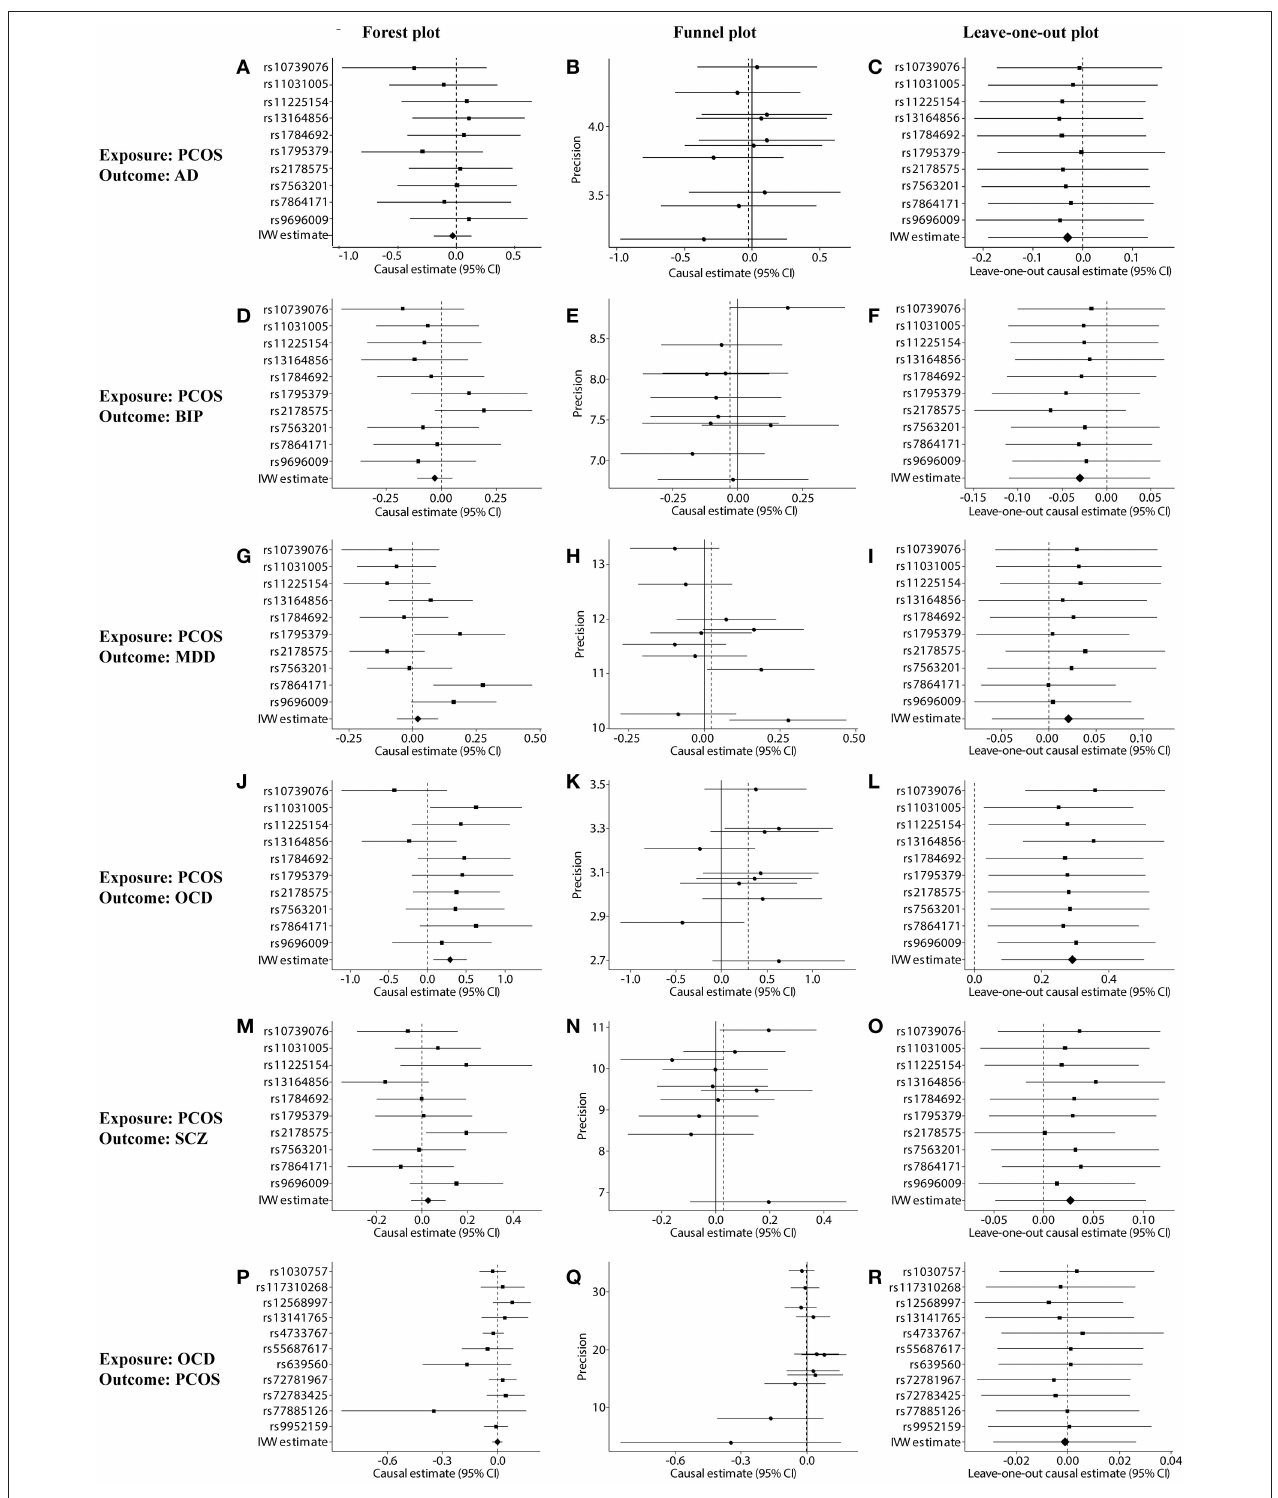
FIGURE 2 | Sensitivity tests of forward and reverse Mendelian randomization (MR) analyses. (A–O) Forest, funnel, and leave-one-out plots for MR analysis between PCOS (exposure) and one of the following outcomes: (A–C) AD, (D–F) BIP, (G–I) MDD, (J–L) OCD, or (M–O) SCZ. (P–R) Forest, funnel, and leave-one-out plots for MR analysis between OCD (exposure) and PCOS (outcome). Plots were generated based on the effect size of the SNP (beta) and its standard error (se). PCOS, polycystic ovary syndrome; AD, anxiety disorder; BIP, bipolar disorder; MDD, major depression disorder; OCD, obsessive compulsive disorder; SCZ, schizophrenia.